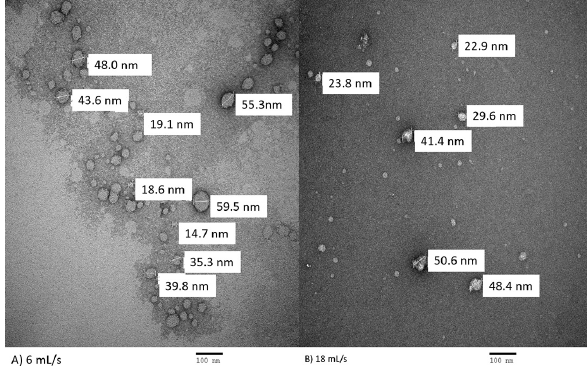
Figure 5: TEM images for (a) 6 mL/s, and (b) 18 mL/s at 1200 rpm and 9:1 ratio.